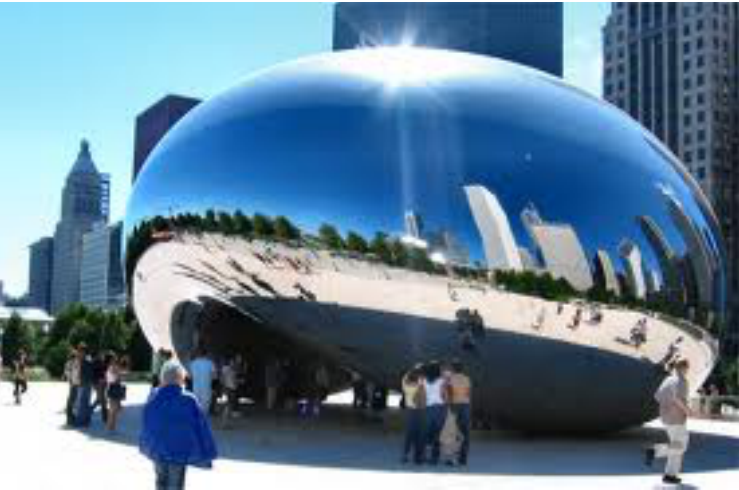
Figure 1. Cloud Gate by Anish Kapoor in Chicago Millennium Park